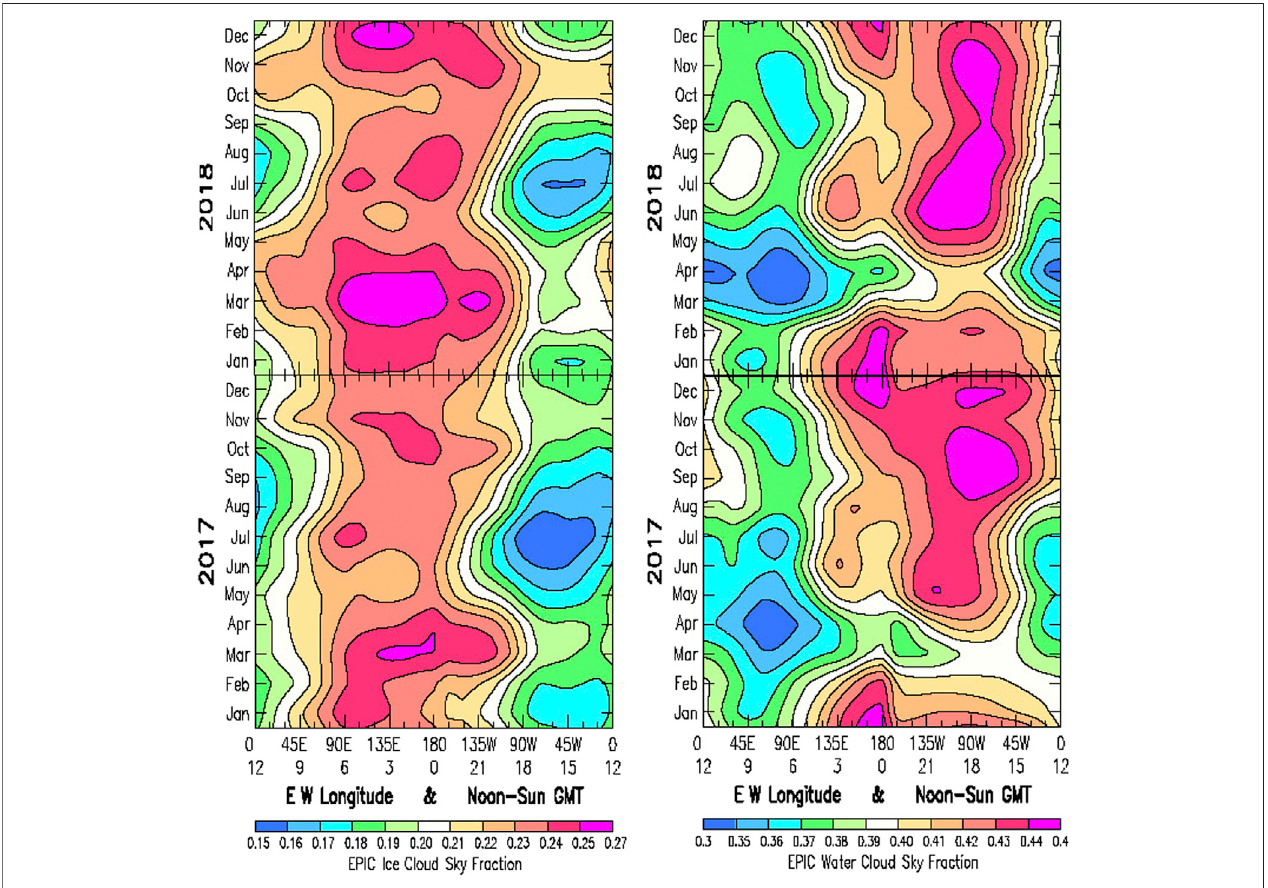
FIGURE 10 | Left : Hovmöller format ice cloud sky fraction from EPIC Composite analysis results for the year 2018 (Upper Left) and 2017 (Lower Left) . Right Panel : Water cloud sky fraction from EPIC Composite analysis results for the year 2018 (Upper Right) , and for year 2017 (Lower Right) .